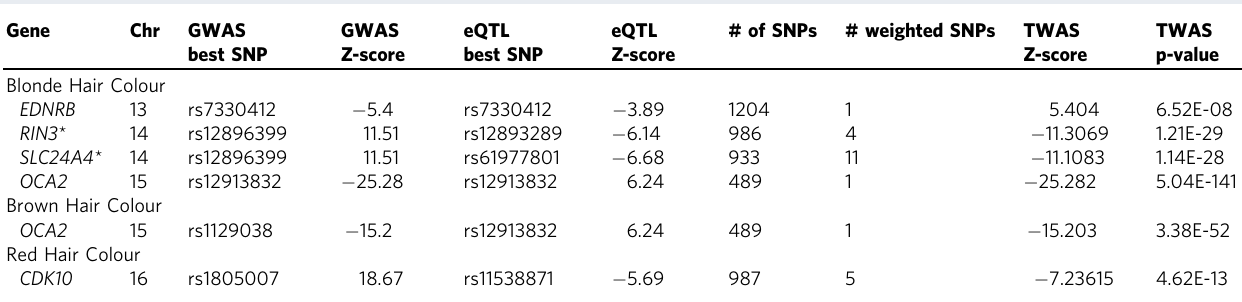
Table 2 Genome-wide signi fi cant genes in the TWAS of the hair colour categories: blonde, brown and red. Gene